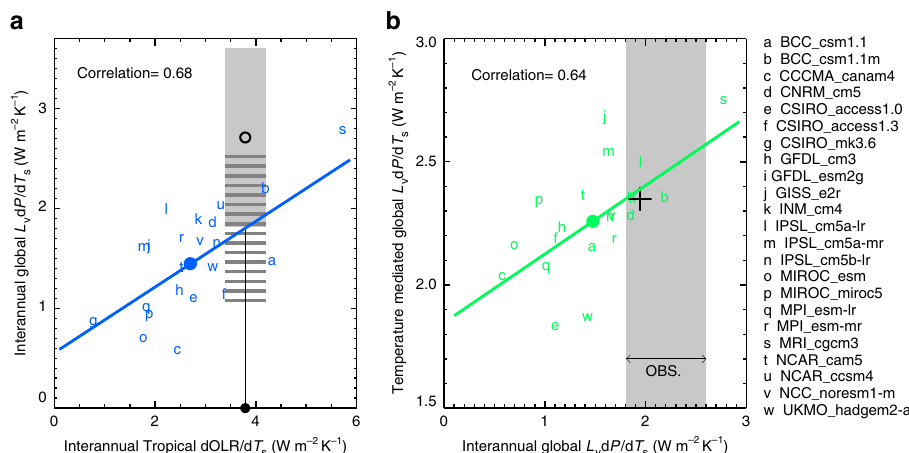
Figure 4 | Emergent constraint on the hydrological sensitivity. ( a ) Interannual global-mean precipitation change per unit surface warming L v d P/ d T s scattered against interannual tropical-mean OLR change per unit surface warming dOLR / d T s for 23 CMIP5 models. The CERES dOLR / d T s (the black dot on the x -axis) with the 95% confidence level marked horizontally in grey shading. The GPCP global-mean L v d P/ d T s is shown in open black circle with the 95% confidence level marked vertically in grey shading. The CERES OLR-constrained L v d P/ d T s estimate based on the linear regression relation between the interannual L v d P/ d T s and dOLR / d T s is marked by grey horizontal lines with their length corresponding to the 95% confidence level. The overlapped range of the GPCP and CERES OLR-constrained L v d P/ d T s is used as the best estimate of observational interannual L v d P/ d T s with the 95% confidence level. ( b ) The temperature-mediated global-mean L v d P/ d T s scattered against the interannual L v d P/ d T s for 21 CMIP5 models. The best estimate of the observational interannual L v d P/ d T s is marked in grey shading. Each model is represented by a lowercase letter. The ensemble model means for the 21 models and the five better-performing models are shown in solid circles and black cross, respectively. The least-squares linear regression lines and correlation coefficients between the x -axis and y -axis variables are